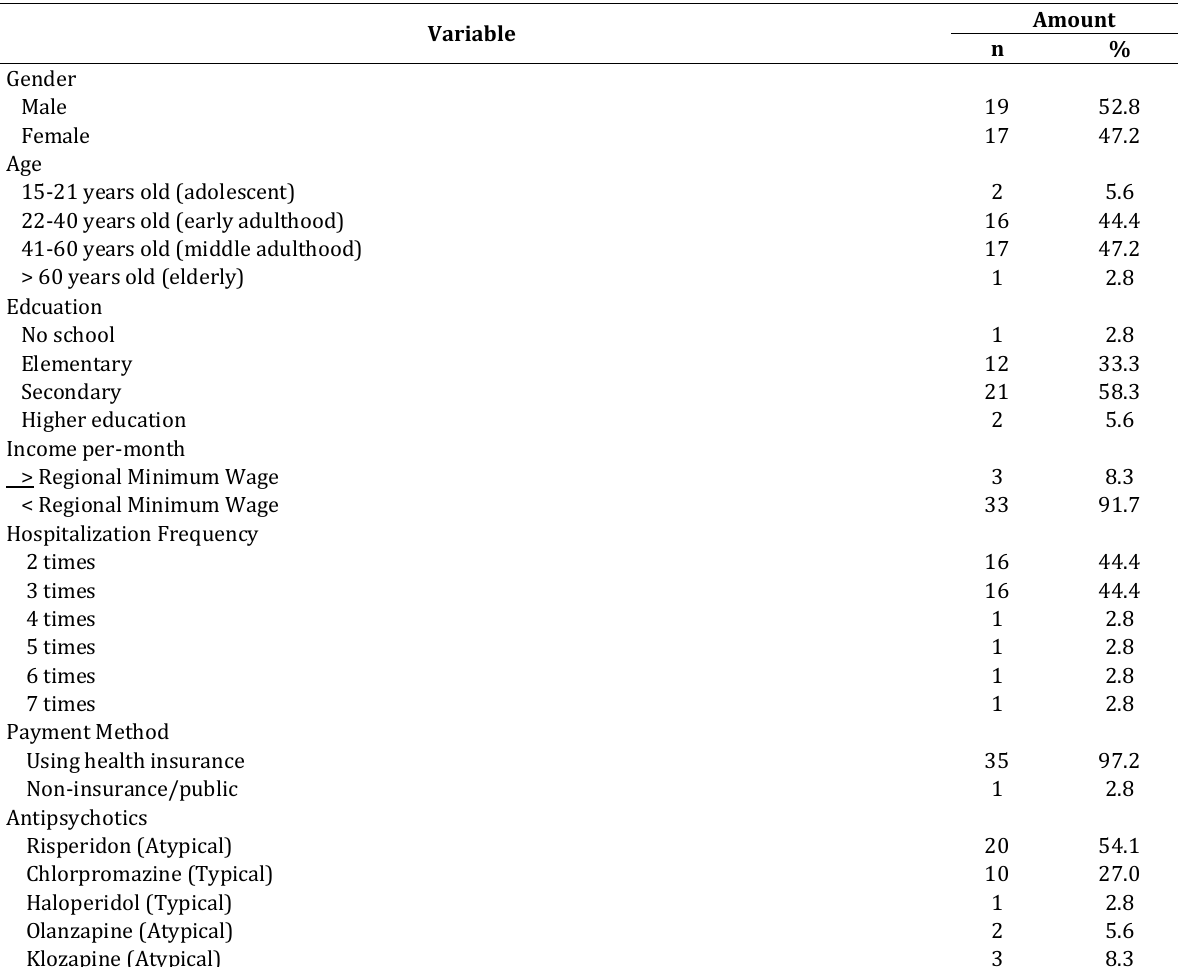
Table 1. The distribution of frequency sociodemography of patient (n=36)